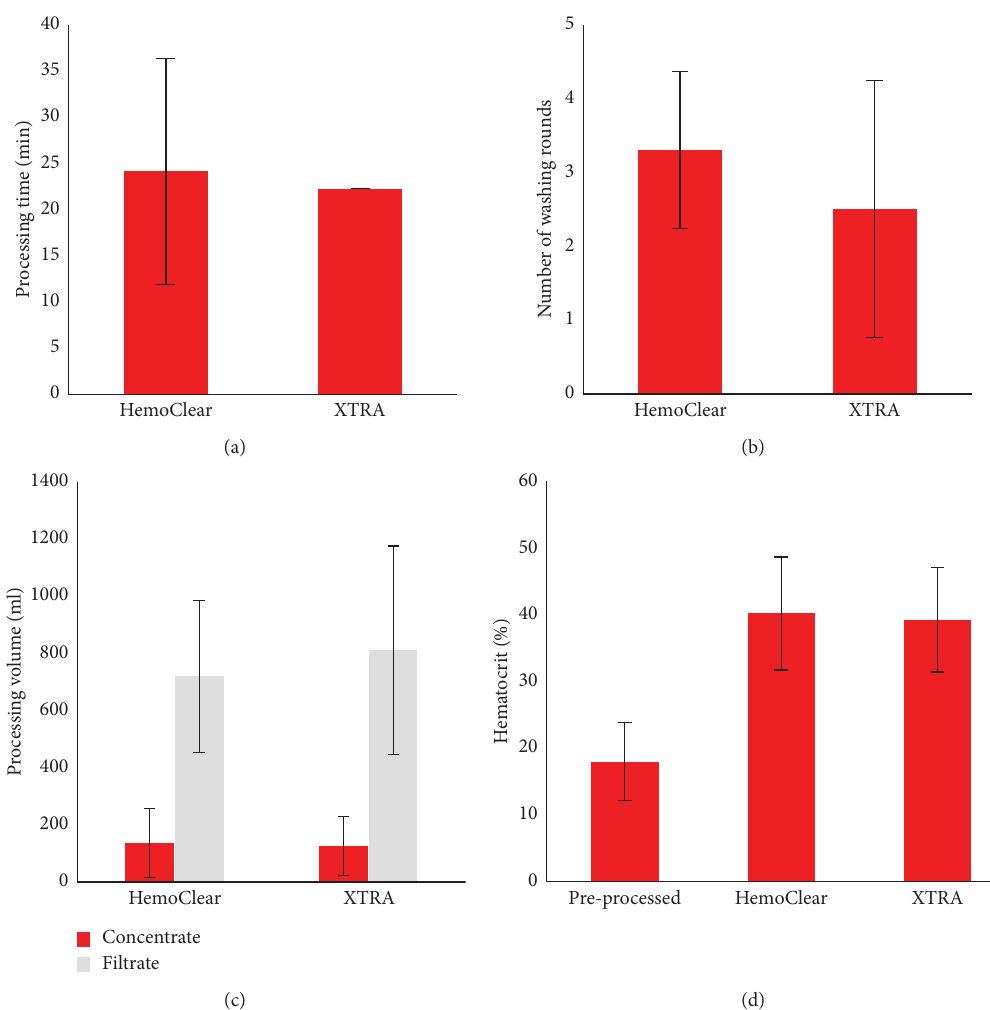
Figure 5: Operational assets (a, b), processing characteristics (c,